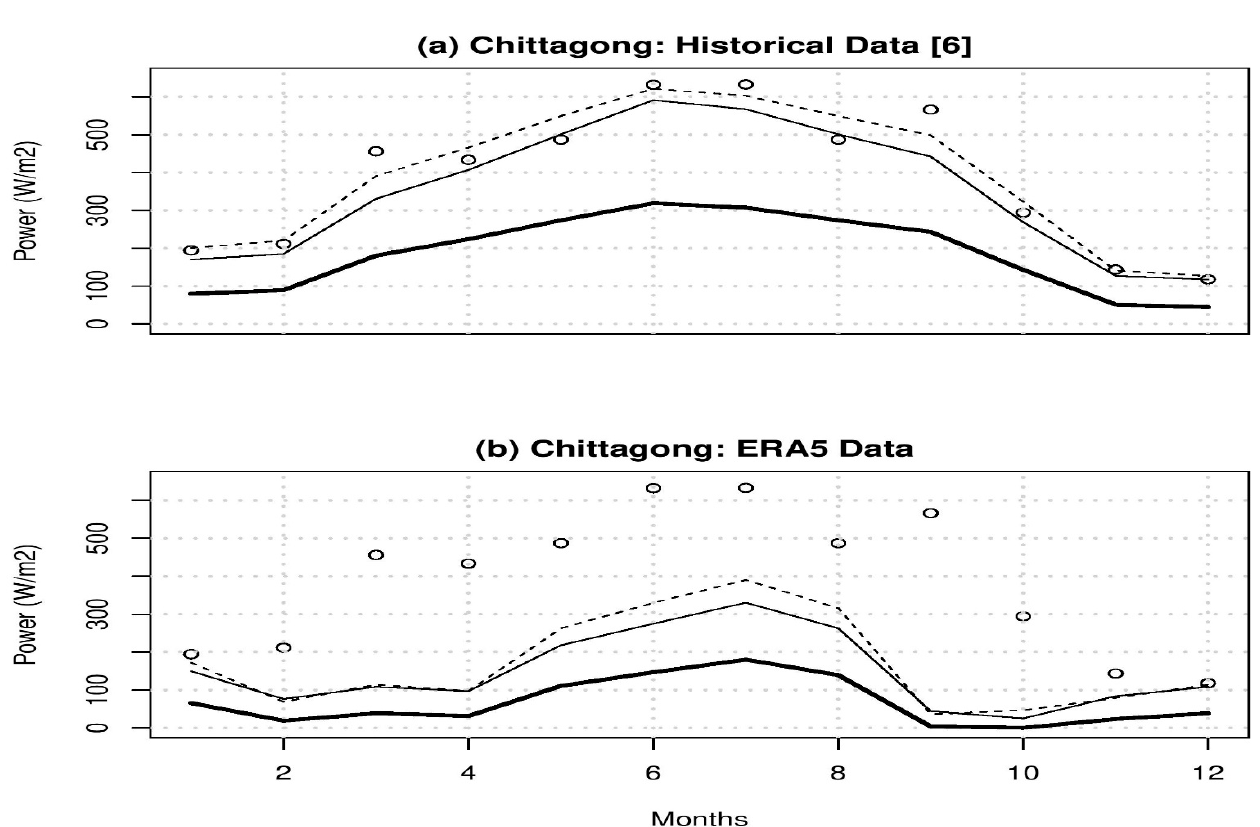
Figure 9. Same as in Figure 8, but valid for observation from GWA power data. The Annual Energy Production (AEP) is carried out utilizing SPPM models. From ERA5, the descriptive statistics for hourly wind speed in 2018 is given in Table 5. Since